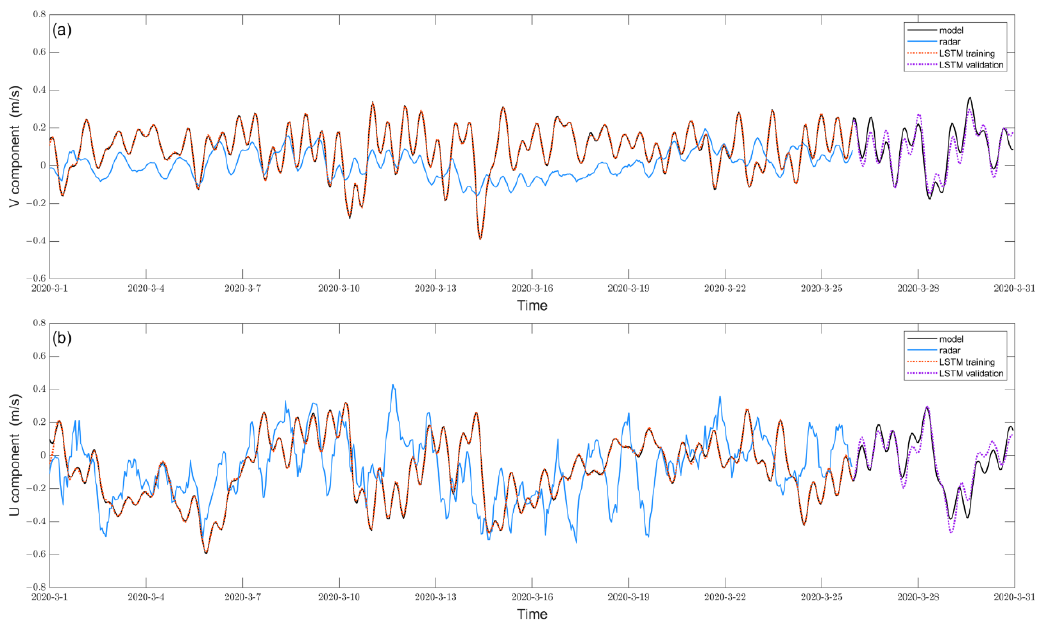
Figure 4. Line charts of point B current velocity for ( a ) the v component and ( b ) the u component. Solid black line: 1 – 30 March model data. Solid blue line: 1 – 25 March HF radar data. Dashed red line: 1 – 25 March LSTM training results. Solid purple line: 26 – 30 March LSTM validation results.